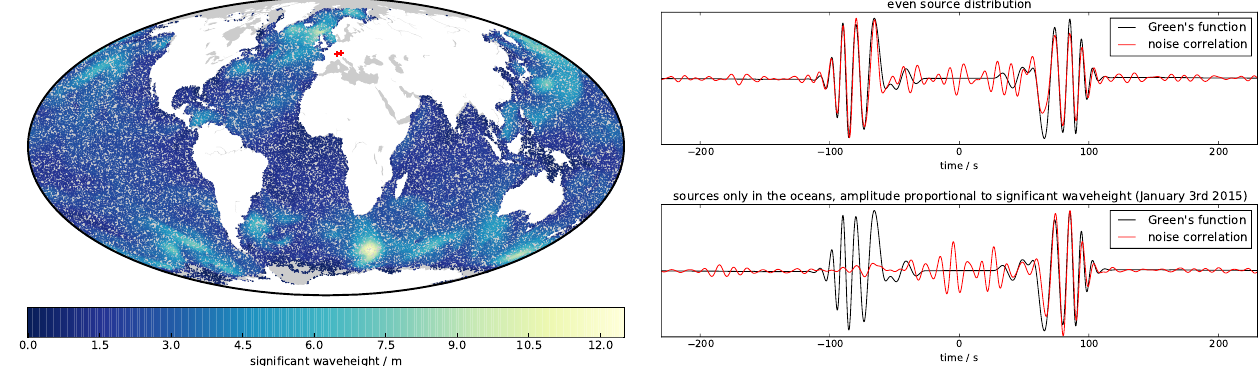
Figure 23. Synthetic ambient seismic noise cross correlations computed with Instaseis. Left: 100000 vertical force sources located in the oceans and amplitude proportional to the significant wave height from the NOAA WAVEWATCH III model on 3 January 2015 (Tolman, 2009). Red crosses indicate the receivers located in Munich and Zurich. Right: cross correlations of 20 days of noise for (top) evenly distributed noise sources and (bottom) the sources in the map, the traces are normalized to their maximum